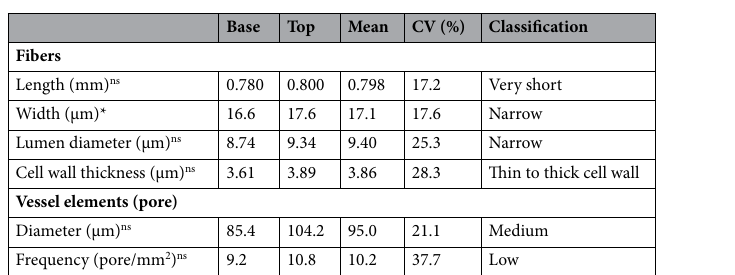
Table 2. Mean dimensions, coefficient of variation and classification of fibers and vessel elements observed in the cross-section in the base and top positions of Pterogyne nitens wood (*significant by the t-test at 5% of probability (p < 0.05); ns not significant).